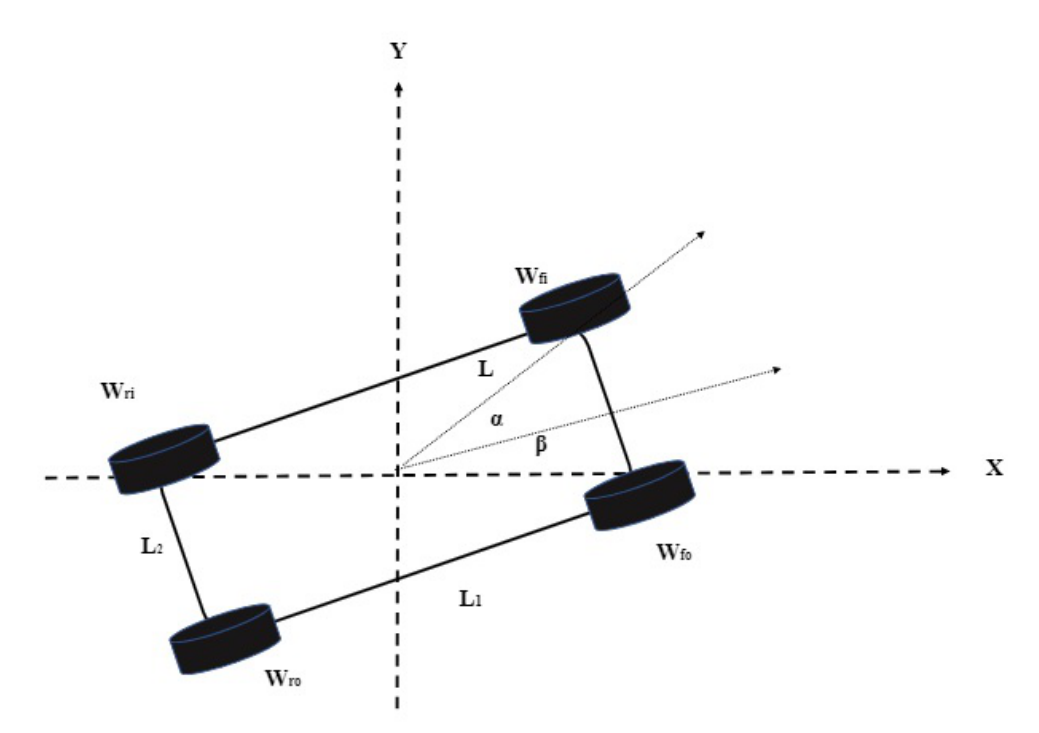
Figure 1. Schematic of the